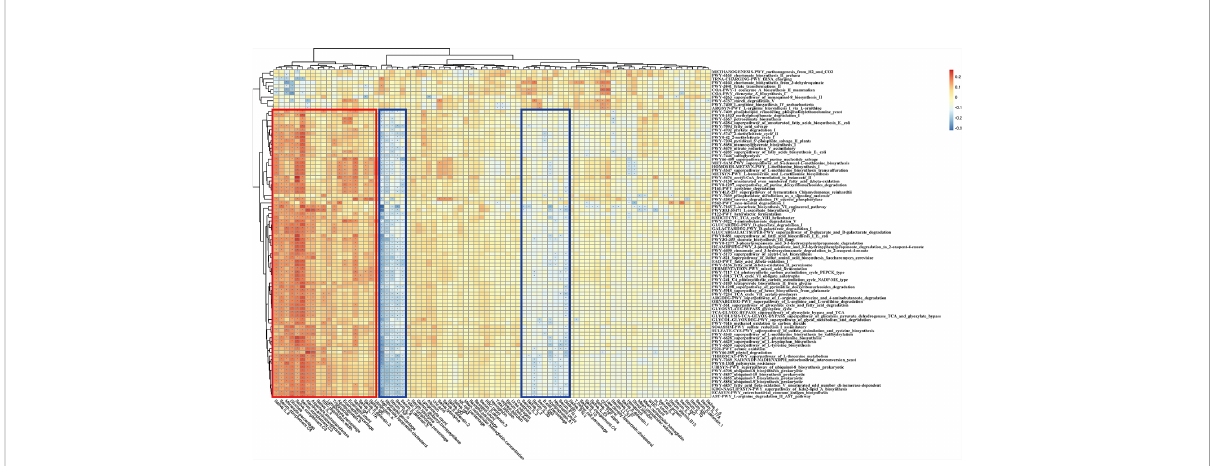
FIGURE 7 Correlation heatmap of gut microbiome-associated metabolic pathways and the blood and saliva factors between the RAU patients and health controls. Blue boxes denote the cluster of negative correlation, those encompassed by the red box represent the cluster of positive correlation. The colors are proportional to the correlation strength, the variation from red to blue represent positive to negative trend. “ * ” means P